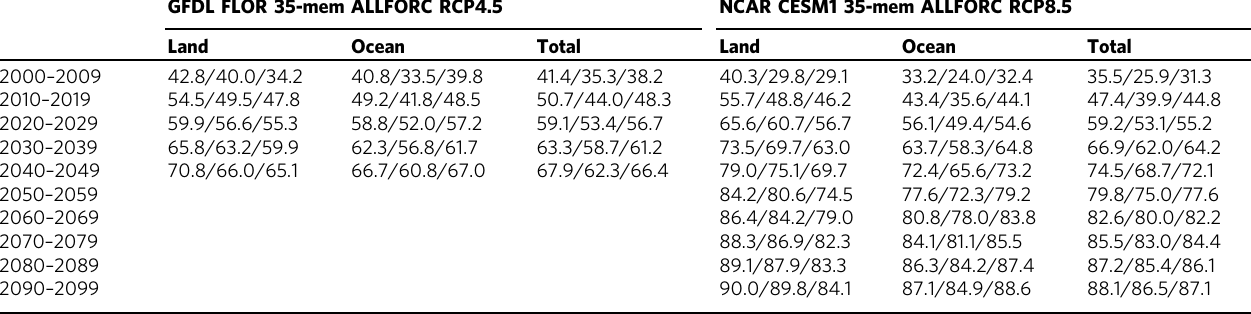
Table 2 Fraction (%) of the global area (weighted by latitudes) with distinguishable shifts in annual/NDJFMA/MJJASO precipitation mean state, respectively GFDL FLOR 35-mem ALLFORC RCP4.5 NCAR CESM1 35-mem ALLFORC